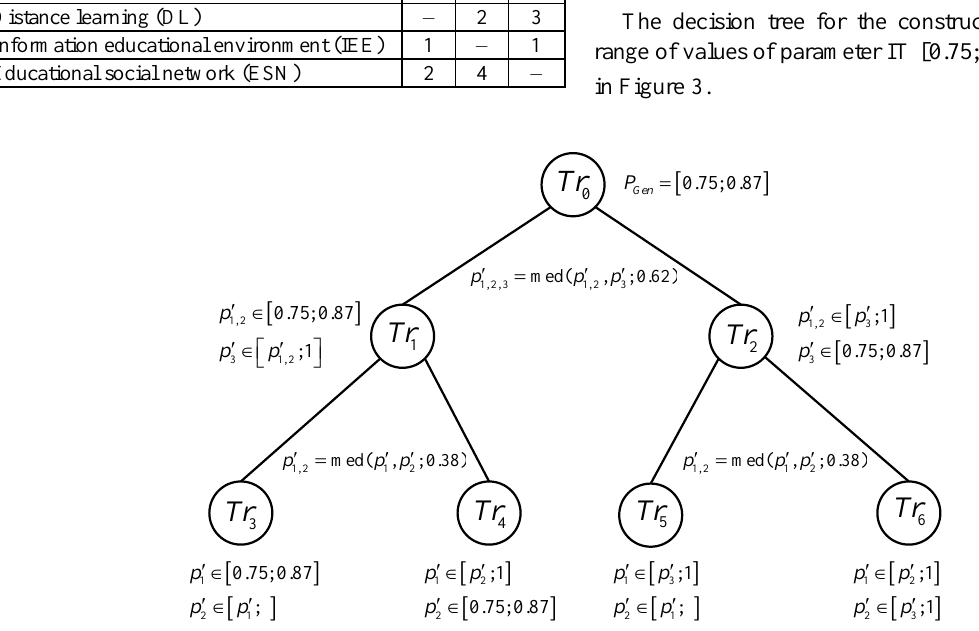
Figure 3 – Decision tree for given example